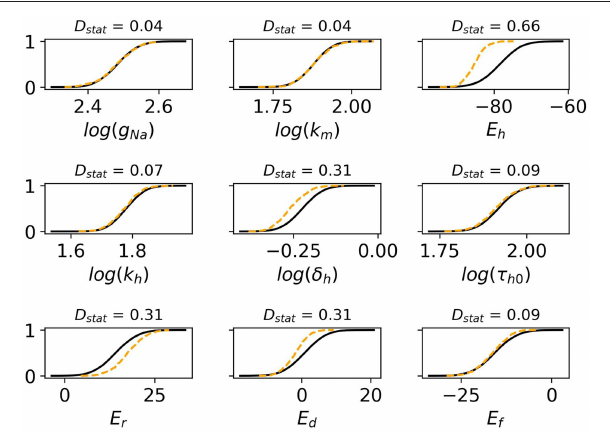
FIGURE 7 | Cumulative distribution functions (CDFs) for selection of nine cell model parameters. Solid black lines are the CDFs of ( p i | AP exhibits spike) and dashed orange lines are the CDFs of ( p i | AP does not exhibit spike). The underlying action potentials are shown in Figures 6D,E . Non-overlapping CDFs (see e.g., E h , δ h , E r , E d ) indicates the value of the parameter statistically impacts where AP exhibits spike or